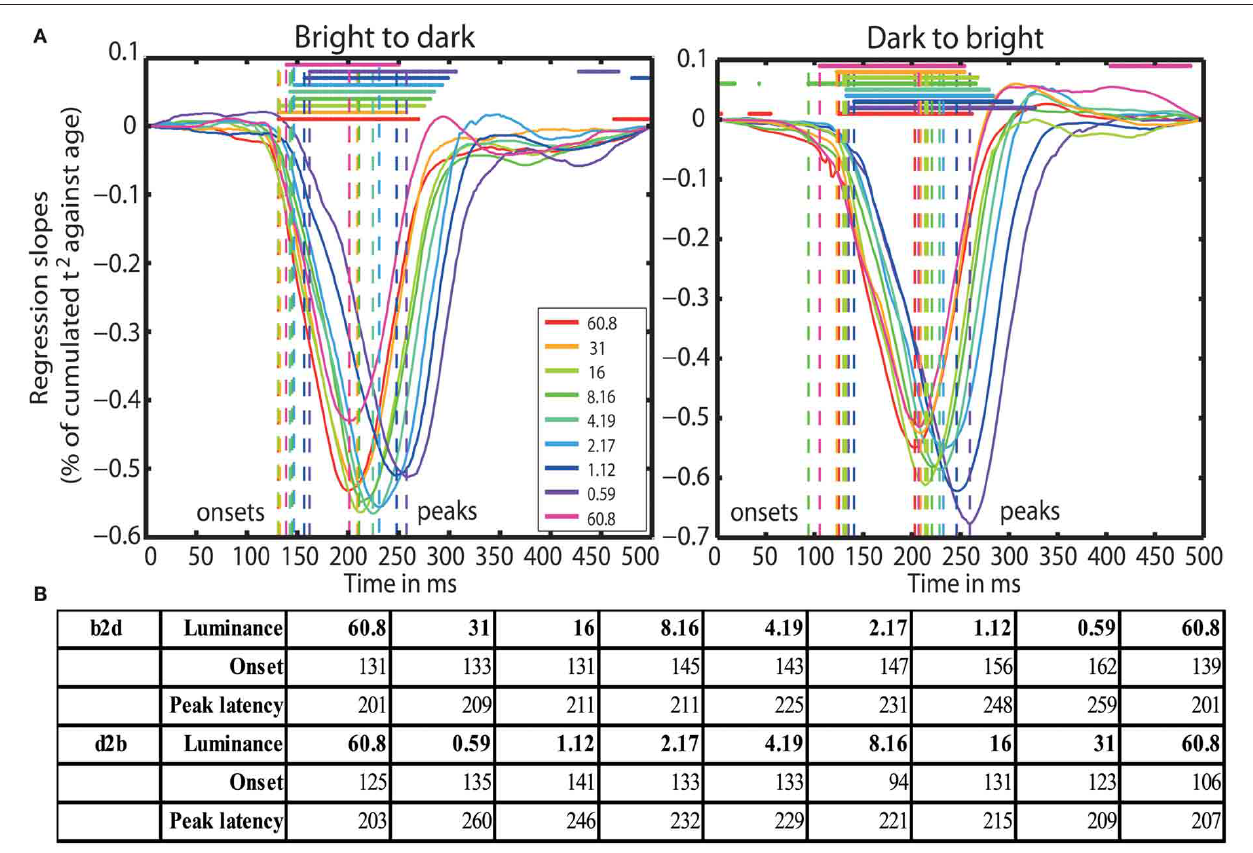
FIGURE 5 | (A) Time-courses of % of cumulated t 2 /age regression slopes. Each curve shows the time-course at one luminance level. Horizontal lines indicate significant regression slopes. Vertical dashed lines mark the onsets